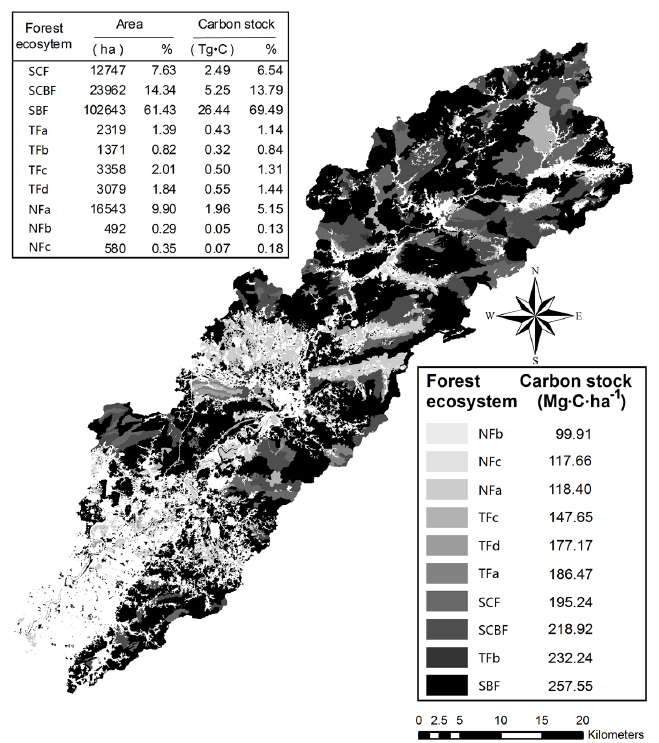
Figure 9. Distribution of forest ecosystem carbon stocks in the Liuxihe River basin. a, b, c, d: plot series representing the further subdivision of the forests measured (Table 1).